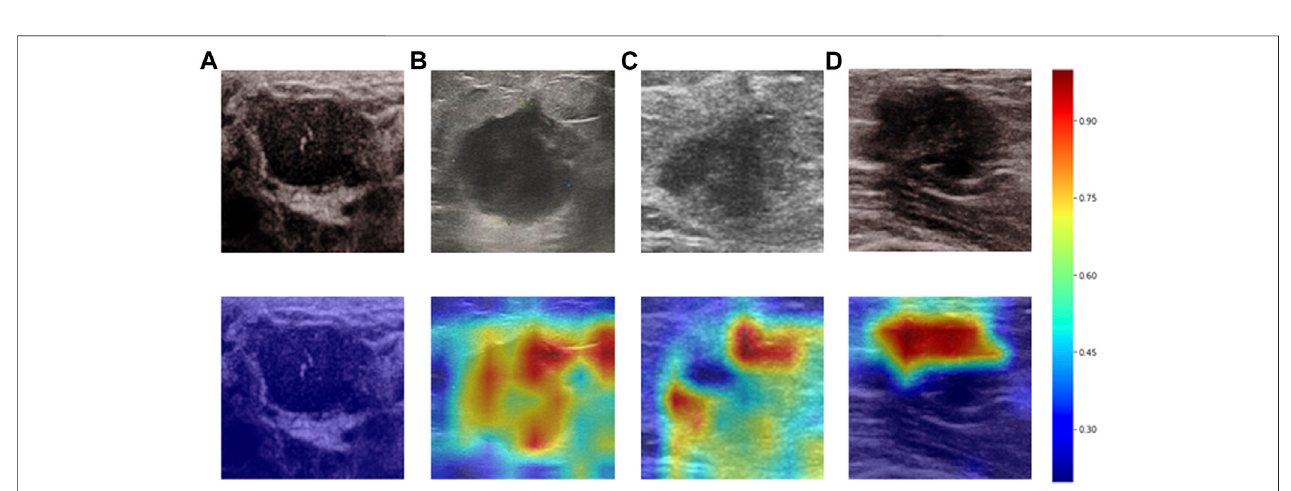
FIGURE 5 | Heatmaps generated by Grad-CAM. The color ranges from blue to red, and represents the signi fi cance value of the region ranging from low to high, respectively,forthepredictionofamalignanttumororALNM. (A) Benigncasewhichwasclassi fi edcorrectly. (B) MalignantmasseswithoutALNM. (C) and (D) Malignant